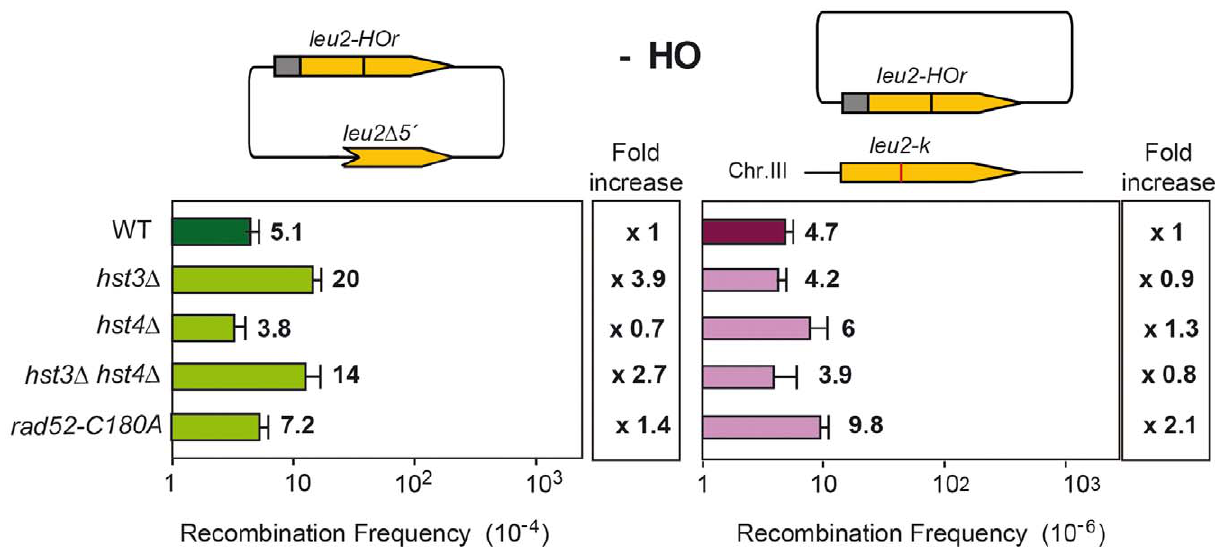
Figure 7. Effect of changes in the state of H3K56 acetylation on spontaneous recombination. Analysis of spontaneous intrachromosomal and plasmid-chromosome recombination in isogenic wild-type (WS), hst3 D , hst4 D , hst4 D hst3 D and rad52-C180A strains.